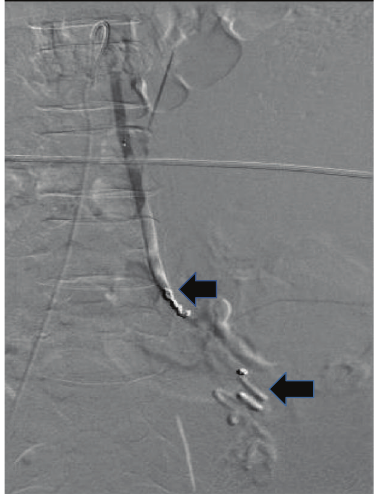
Figure 4: Post-left ovarian artery embolization: this shows micro- coils placed proximal and distal to the aneurysm (arrows).